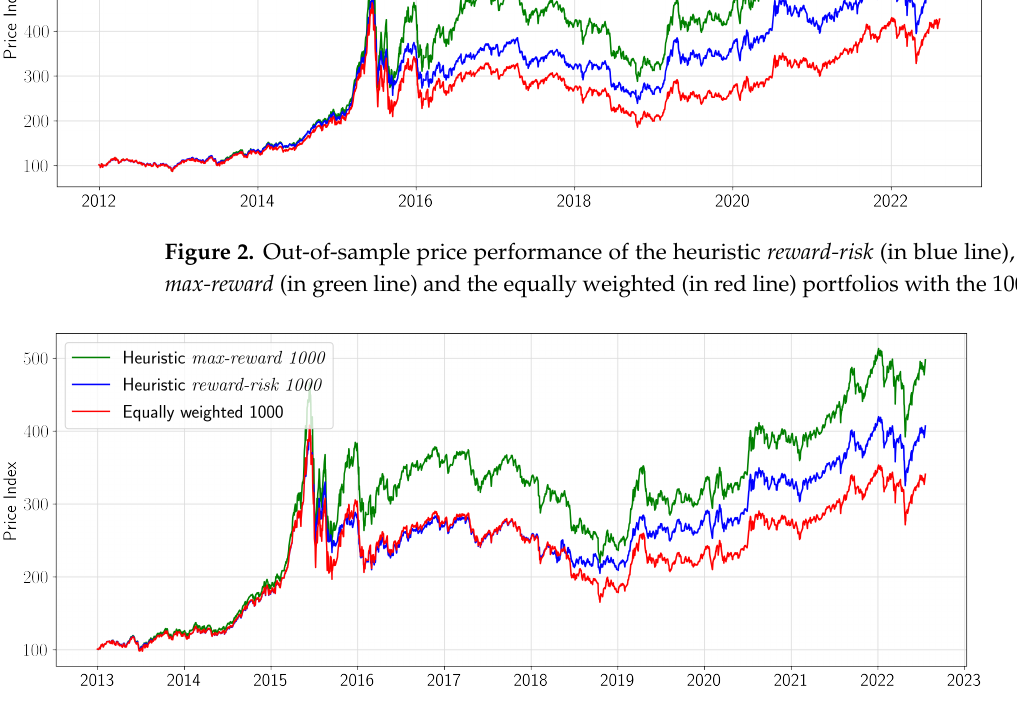
Figure 3. Out-of-sample price performance of the heuristic reward-risk (in blue line), the heuristic max-reward (in green line) and the equally weighted (in red line) portfolios with the 1000